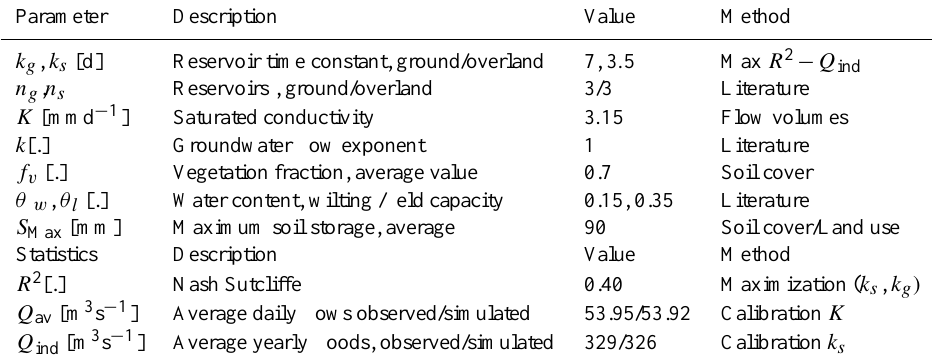
Table 3. Oglio at Sarnico. Hydrological model parameters. In italics are values calibrated against observed discharges Parameter Description Value Method k g , k s [d] Reservoir time constant, ground/overland 7, 3 . 5 n g , n s Reservoirs , ground/overland 3/3 Literature K [mmd − 1 ] Saturated conductivity 3 . 15 Flow volumes k [.] Groundwater flow exponent 1 Literature f v [.] Vegetation fraction, average value 0.7 Soil cover θ w , θ l [.] Water content, wilting /field capacity 0.15,